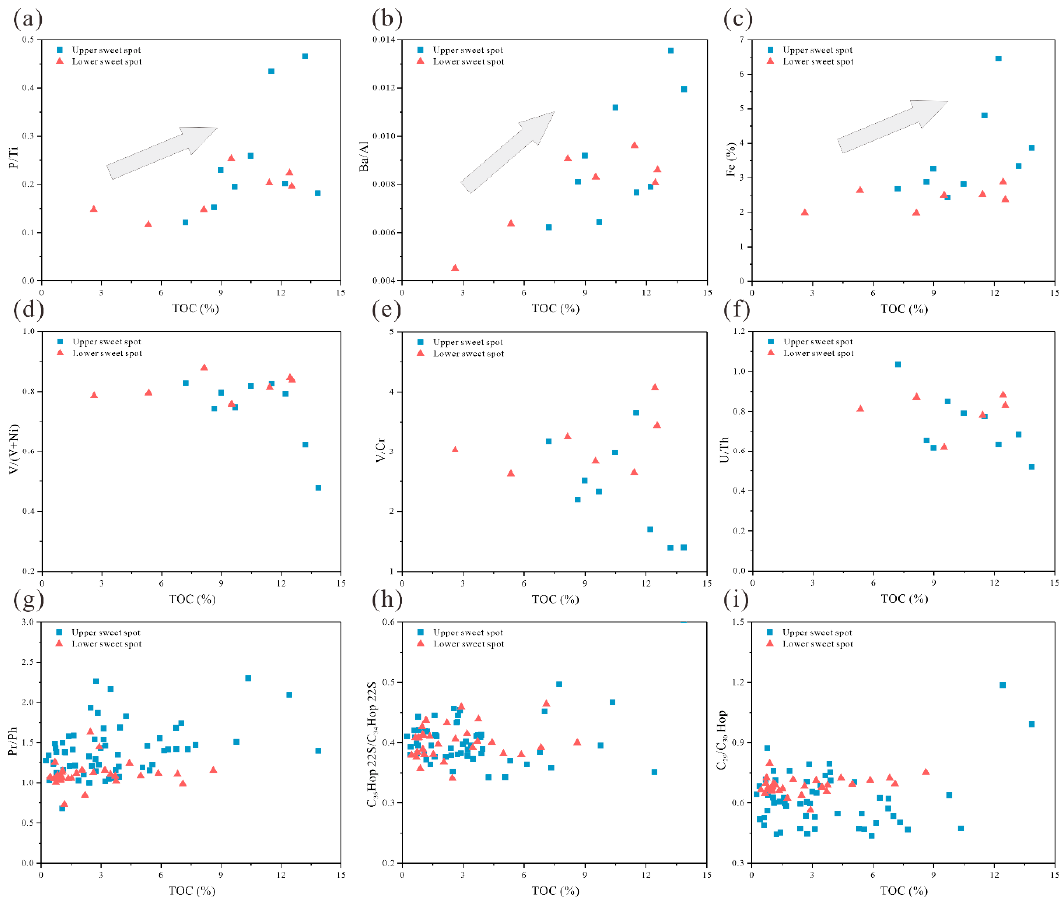
Figure 15. ( a , b , c ) Correlation between paleoproductivity indicators viz. P / Ti, Ba/Al, and Fe content Figure 15. ( a – c ) Correlation between paleoproductivity indicators viz. P / Ti, Ba / Al, and Fe content and and TOC. ( d , e , f , g , h , i ) Correlation between water column redox condition indicators viz. V / (V + TOC. ( d – i ) Correlation between water column redox condition indicators viz. V / (V + Ni), V / Cr, U / Th, Ni), V/Cr, U/Th, Pr/Ph, C 35 22S hopane/C 34 22S hopane, and C 29 norhopane/C 30 hopane and TOC. Pr / Ph, C 35 22S hopane / C 34 22S hopane, and C 29 norhopane / C 30 hopane and Li et al. [97], Ding et al. [98], and Liu et al. [99] found volcanic tuff and exhalative rocks with